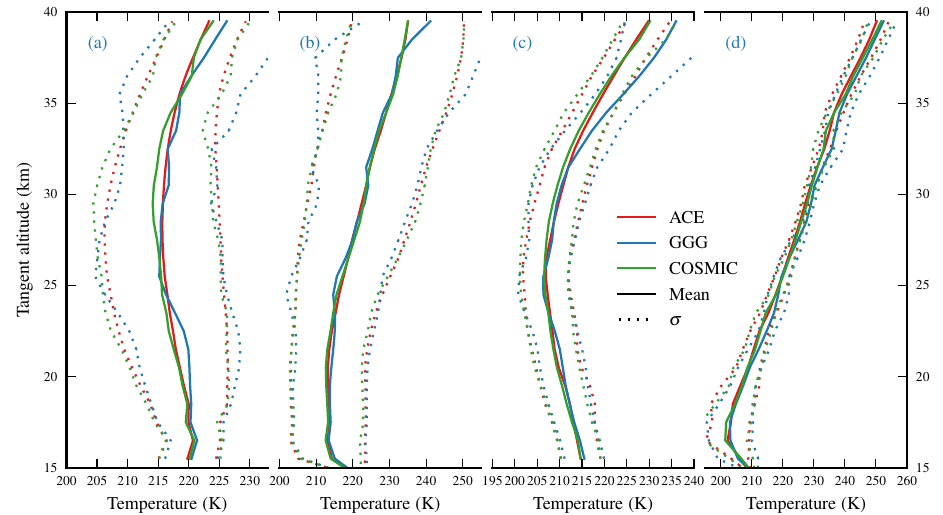
Figure 7. Mean temperature profiles retrieved by ACE-FTS v3.5 (red), GGG (blue), and COSMIC (green) for sets: (a) Arctic fall, (b) Arctic winter, (c) Antarctic spring, and (d) low latitudes. Means are solid lines, and standard deviations are dashed. The maximum altitude of the COSMIC data set is 40km.